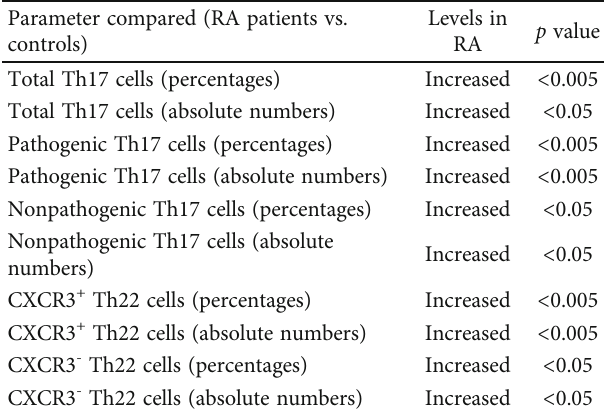
Table 2: Summary of comparisons and p values of the levels of the di ff erent T cell subsets analyzed in blood samples from patients with RA and healthy